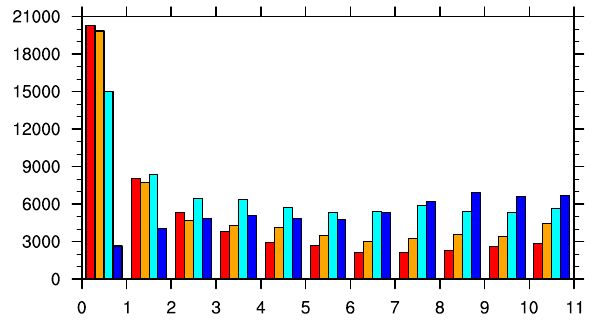
Fig. 13. Rank histograms for the 10.8 µ m BT at forecast ranges of 6 h (red boxes), 12 h (orange), 18 h (cyan) and 24 h (blue).